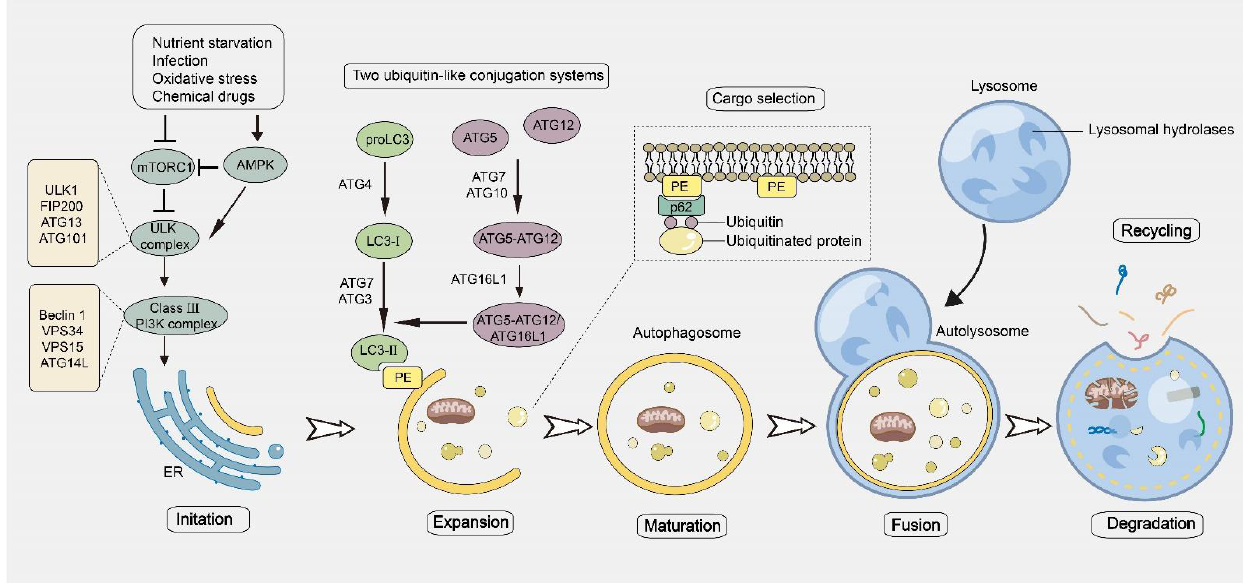
Figure 1. The progress of autophagy. Various stress conditions such as nutrient starvation, infec- tion, oxidative stress, and chemical drugs lead to an increase in mTORC1 suppression and AMPK activation. This can activate the ULK1 complex through a number of phosphorylation cascades. Subsequently, phagophores are formed at the autophagy initiation site of the endoplasmic reticulum, and the phagophores envelop substrates and extend continuingly until forming a double-layered vesicle named autophagosomes with the participation of various autophagy proteins. Finally, in- tact autophagosomes fuse with the lysosomes to form autolysosomes where the substrates will be degraded by hydrolytic